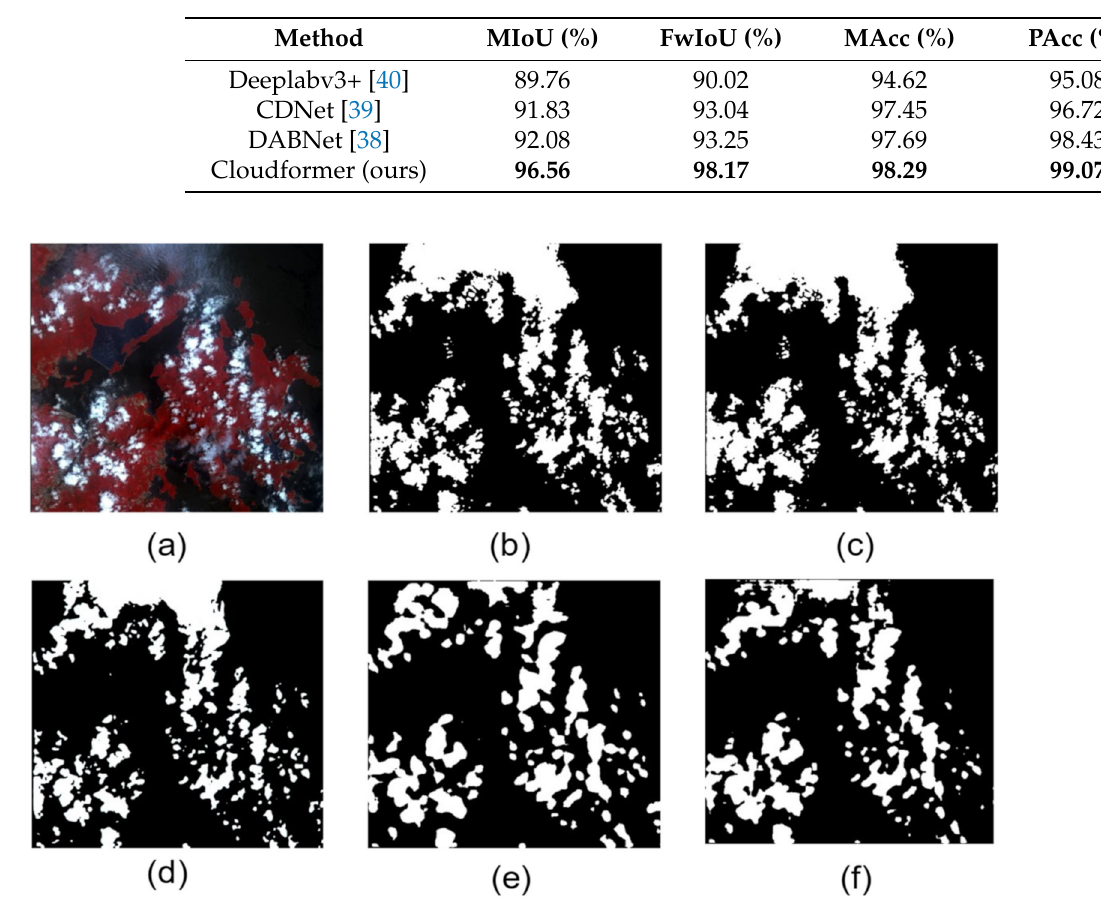
Figure 8. Comparison of different cloud-detection methods on the AIR-CD dataset. ( a ) Image. ( b ) Ground truth. ( c ) Cloudformer. ( d ) DABNet. ( e ) Deeplabv3+. ( f )